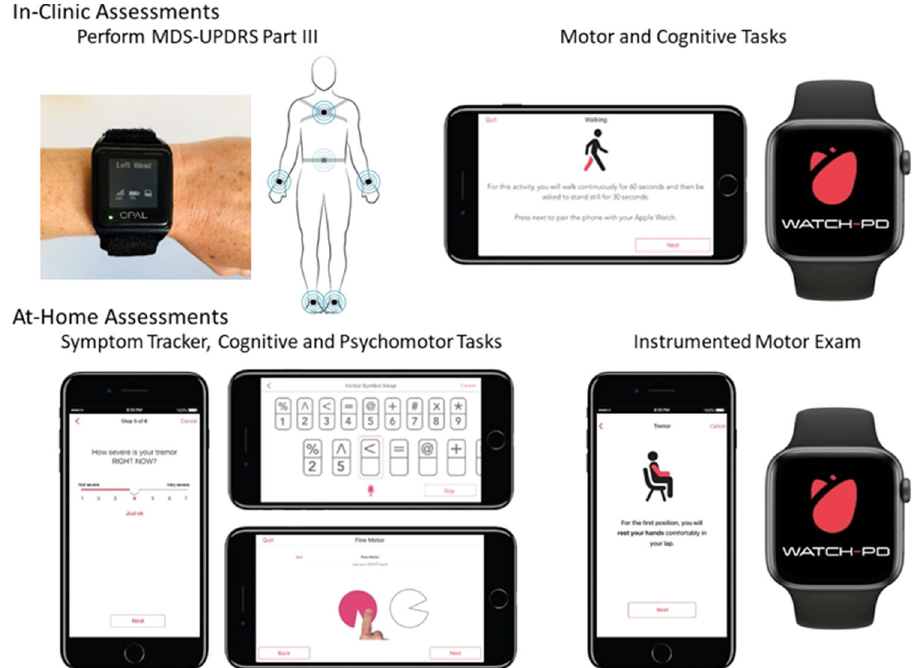
Fig. 5 Digital devices evaluated in-clinic and at-home during the study. MDS-UPDRS Movement Disorder Society-Uni fi ed Parkinson ’ s Disease Rating Scale. Copyrighted images of BrainBaseline ’ s Movement Disorders Mobile Application were reprinted with permission by Clinical ink (Horsham, PA). Copyrighted images of APDM Wearable Technology were reprinted with permission by APDM Wearable Technologies, a Clario Company (Portland,